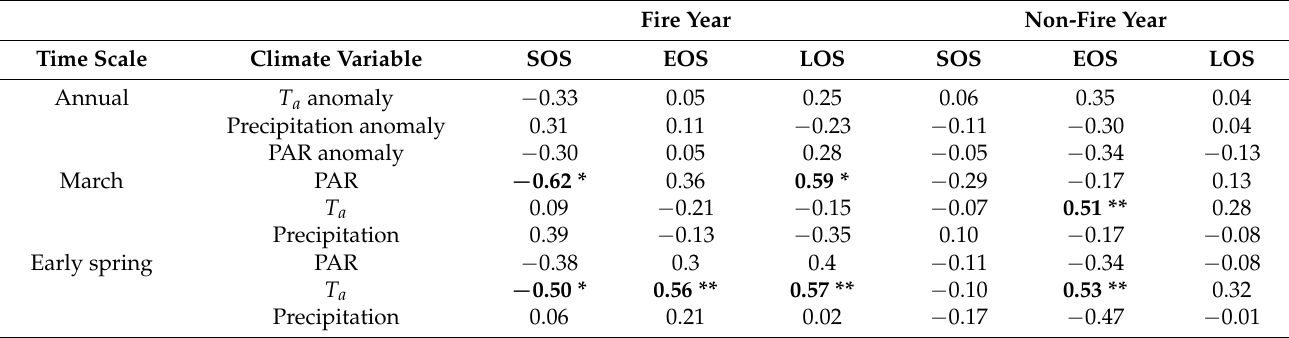
Table 3. Spearman correlation coefficients relating start of growing season (SOS), end of growing season (EOS) and LOS (length of growing season) to interannual, March, and early spring (January to March) air temperature ( T a ), PAR and cumulative precipitation anomalies by site. T a ( ◦ C) and PAR ( µ mol m − 2 s − 1 ) were estimated as averages, precipitation as cumulative, for years with and without prescribed